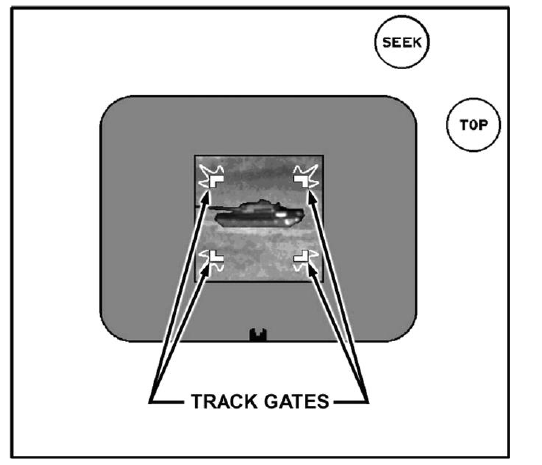
Figure 4 – Target thermal reflection detection – “Target